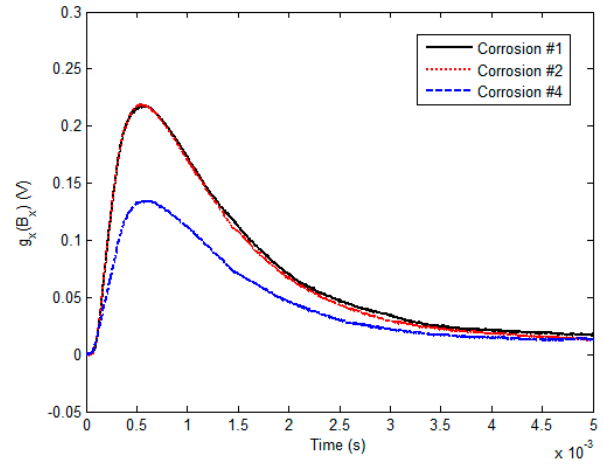
Figure 8. Gradient-field signals with respect to Corrosion #1, Corrosion #2 and Corrosion #4.